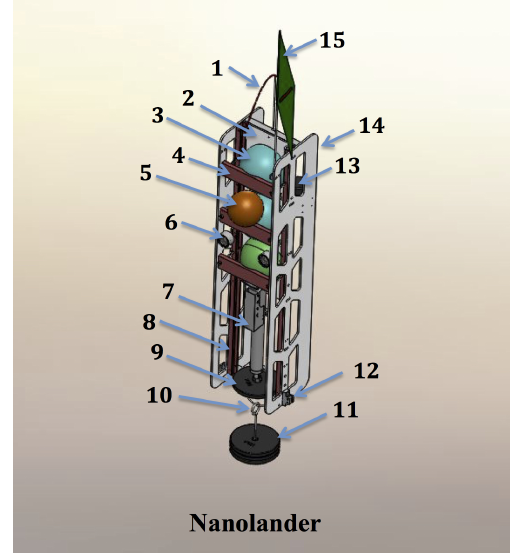
Figure 2. A detailed schematic of the Nanolander DOV BEEBE components: (1) spectra lifting bale; (2) high-density polyethylene (HDPE) centerplate; (3) ∼ 25cm polyamide spheres stacked top, middle, and bottom (see the description in Sect. 2.1); (4) sphere retainer; (5) auxiliary ∼ 18cm flotation sphere; (6) oil-filled LED lights; (7) Sea-Bird MicroCAT-ODO in the lower payload bay; (8) central fiberglass frame; (9) stabilizing counterweight; (10) an- chor slip ring; (11) expendable iron anchor (bar bell weights); (12) burn-wire release and mount (one port side, one starboard side); (13) EdgeTech hydrophone for acoustic command and tracking; (14) HDPE side panels; and (15) surface recovery flag. Not shown: drop arm on front (see Fig. 1b and